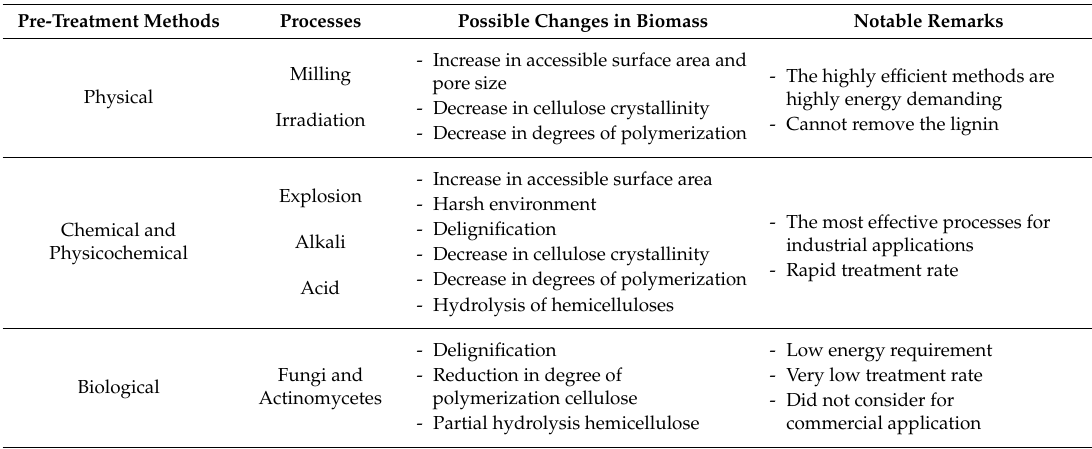
Table 1. Typical methods for pre-treatment of lignocellulosic materials